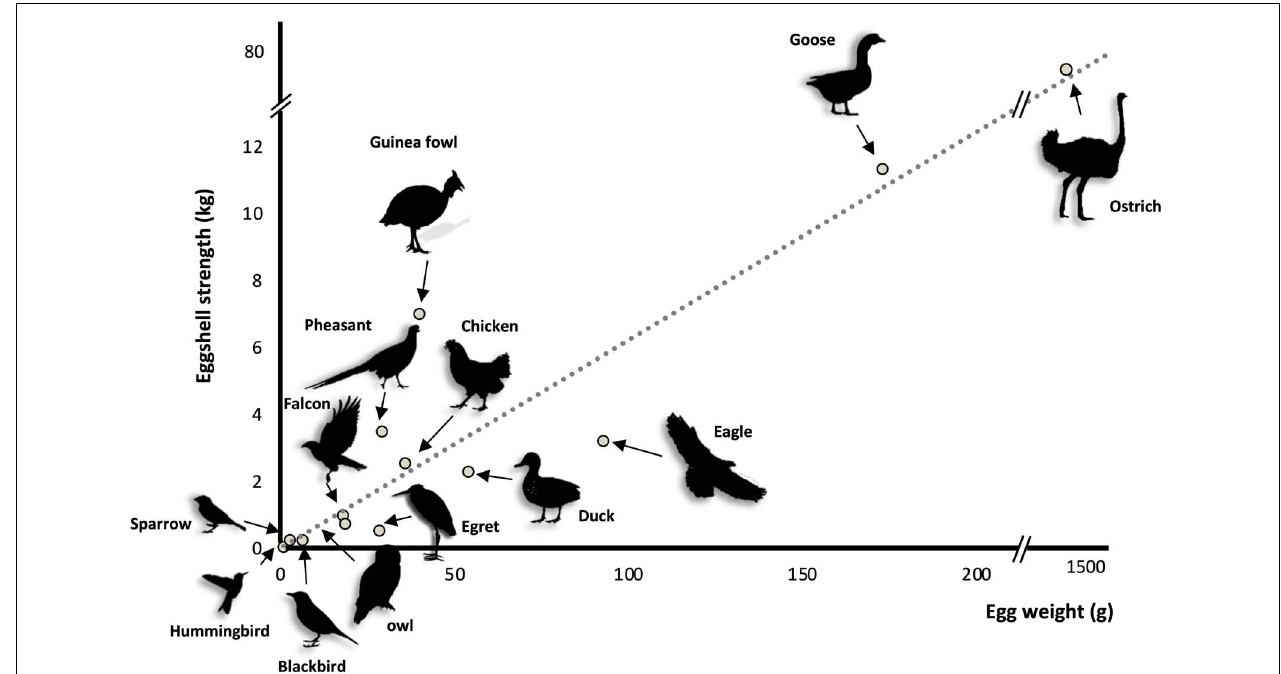
FIGURE 2 | Eggshell strength as function of egg weight in thirteen bird species [adapted from Ar et al.